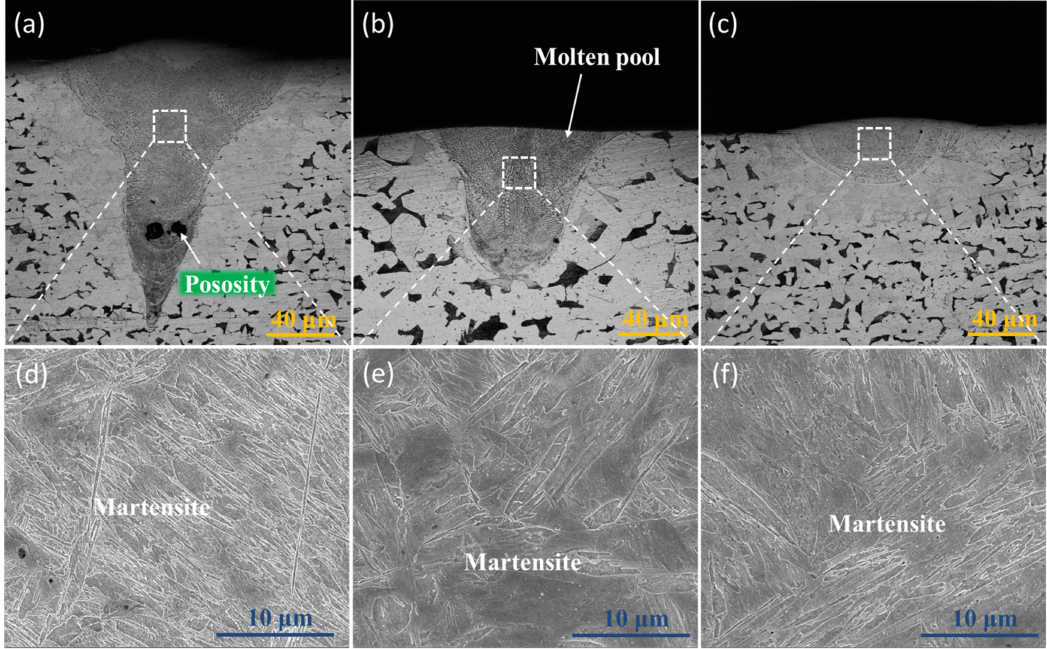
Figure 6. Molten pool morphologies and corresponding microstructural SEM images of SLM low-alloy steel samples grown with di ff erent EADs: ( a , d ) EAD = 284 J / mm 2 ; ( b , e ) EAD = 71 J / mm 2 ; ( c , f ) EAD = 29 J / mm 2